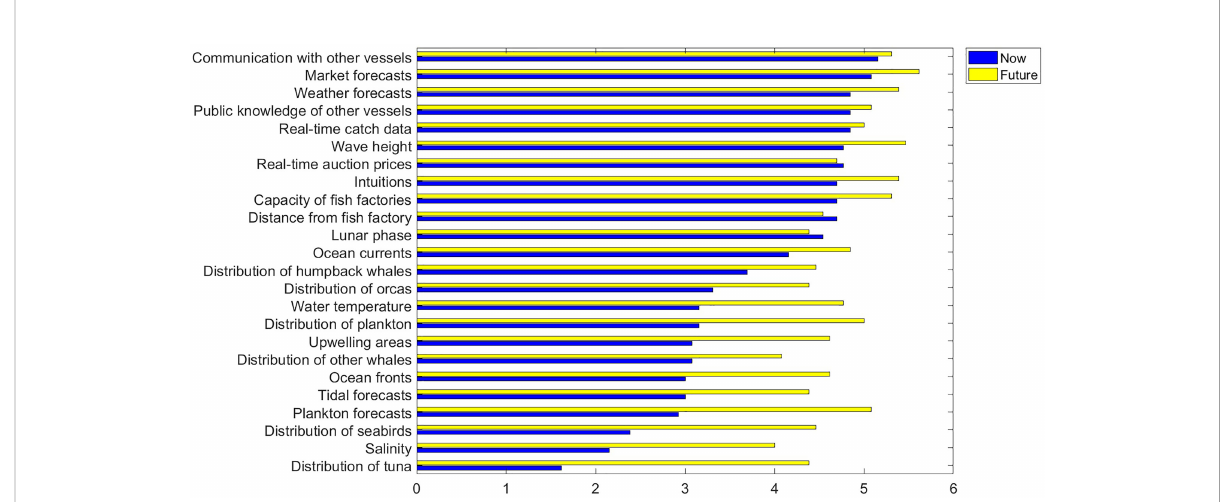
FIGURE 3 Response to Question: How important are the following factors for choosing a fi shing spot during the season? The blue bars indicate how important they are now, while the yellow bars signal the importance of better information in the future. The bars display the mean value